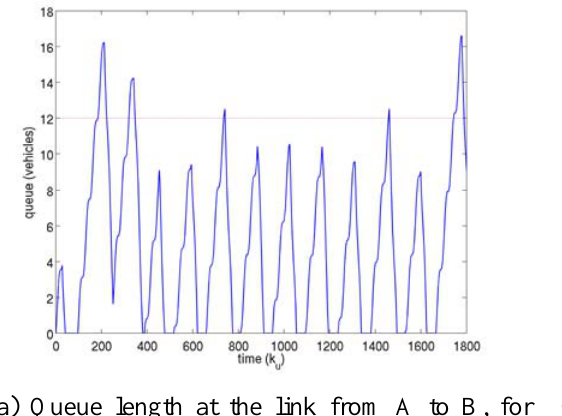
European Journal of Transport and Infrastructure